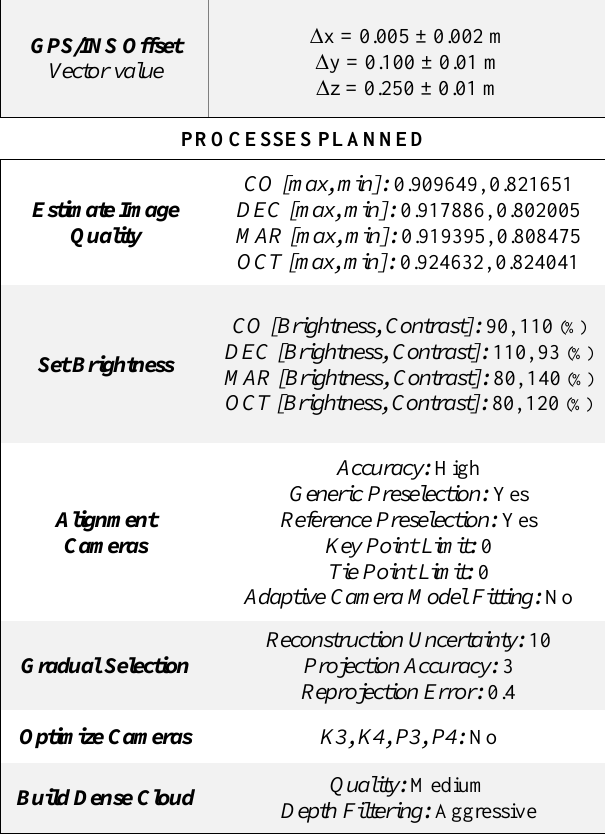
Table 1. Summary sheet of the parameterization used in Agisoft Metashape processing. In Reference Settings, the parameterizations adopted are shown in order to make the workspace consistent with the instrumental limits and the image space of the software used. In Processed Planned, the choices made in the processes carried out. In particular, the labels DEC, MAR, OCT and CO indicate respectively the datasets of December, March, October and the one obtained by Co- Alignment. In Optimize Cameras only the camera self- calibration parameters, belonging to the Model of Brown, not used in the BBA are